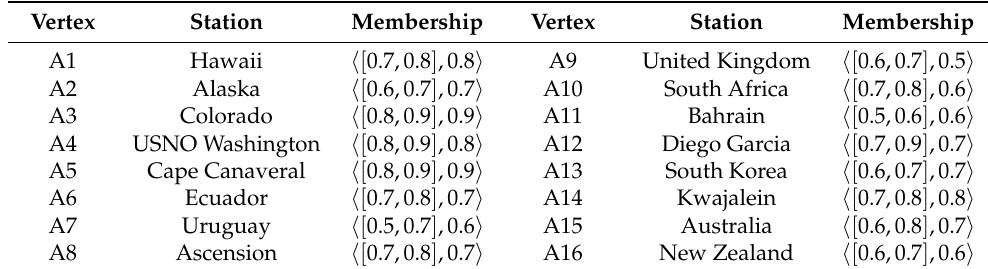
Figure 11. the CG with the vertices of the monitor stations. (Presentation to Civil GPS Service Interface Committee at ION GNSS, 2016, https://www.gps.gov/cgsic/meetings/2016/wong.pdf (accessed on 12 January 2022), Approved for Public Release, 16-603). It seems necessary to have stations for the monitoring station centralization and support. Therefore, in this graph, we are looking for a set of stations that strongly cover the connection between other stations. The cubic membership values of monitoring stations and the connection between them are shown in Tables 2 and 3. Table 2. Cubic membership values of monitoring stations.